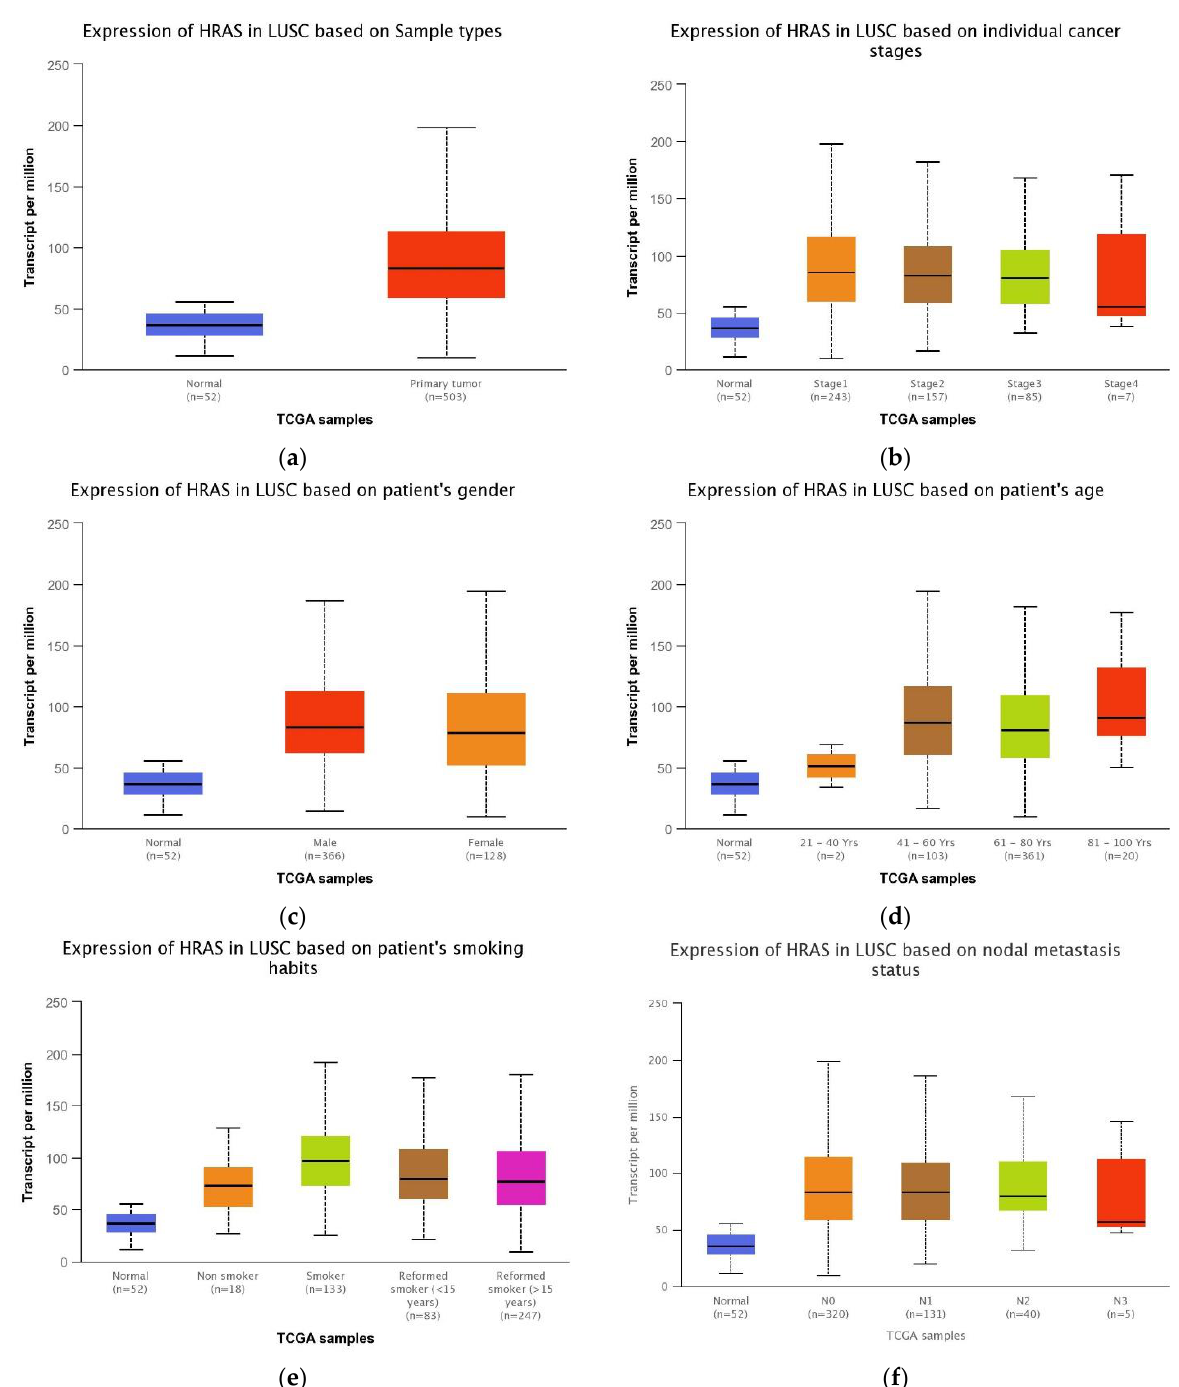
Figure 6. HRAS expression profile in lung squamous cell carcinoma. Box-whisker plots show the expression of KRAS in normal and tumor samples ( a ), tumor subgroups based on individual cancer stages ( b ), patient sex ( c ), age ( d ), smoking status ( e ), nodal metastasis ( f ) (Data derived from the UALCAN server (http://ualcan.path.uab.edu/ (accessed on 15 June 2022))).